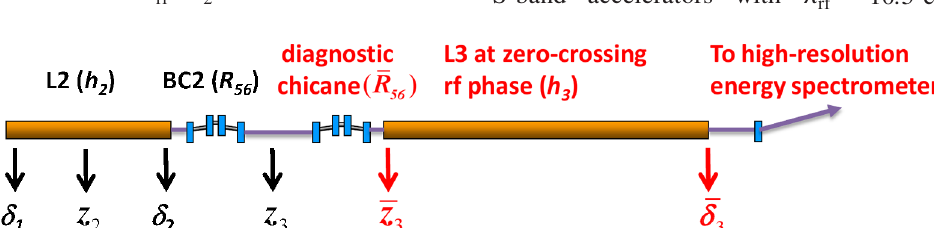
FIG. 1. Schematic setup for short-bunch measurement using a chicane and an rf linac. The arrows give the locations at which the various energy and position symbols apply. In red are parameters that are changed for the purpose of the bunch length